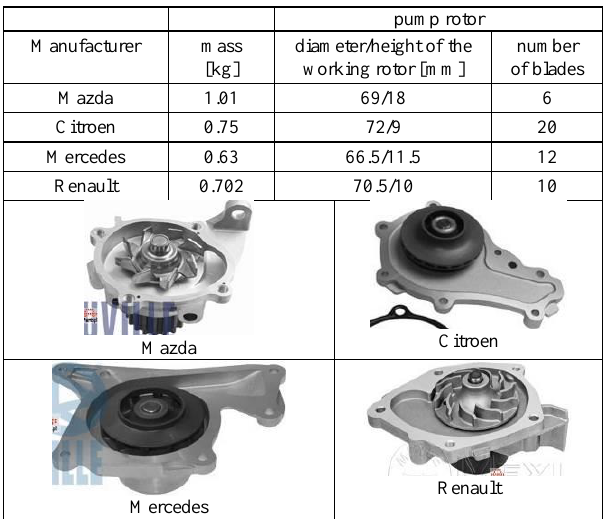
Table 1. Parameters of analyzed CP [21]